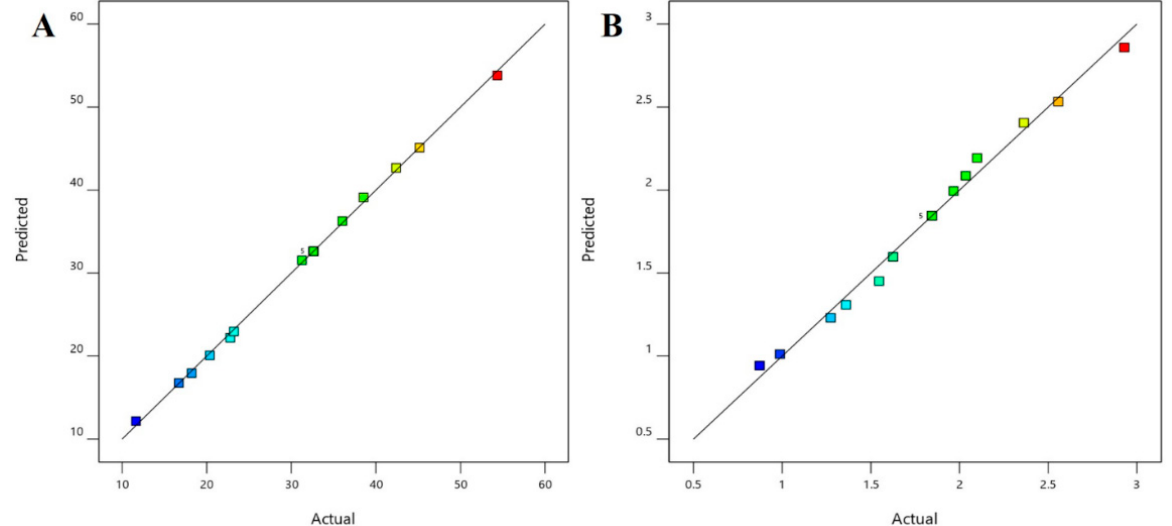
Figure 3. Comparison of predicted and actual values ( A ) permeation and ( B ) drug in the nail.